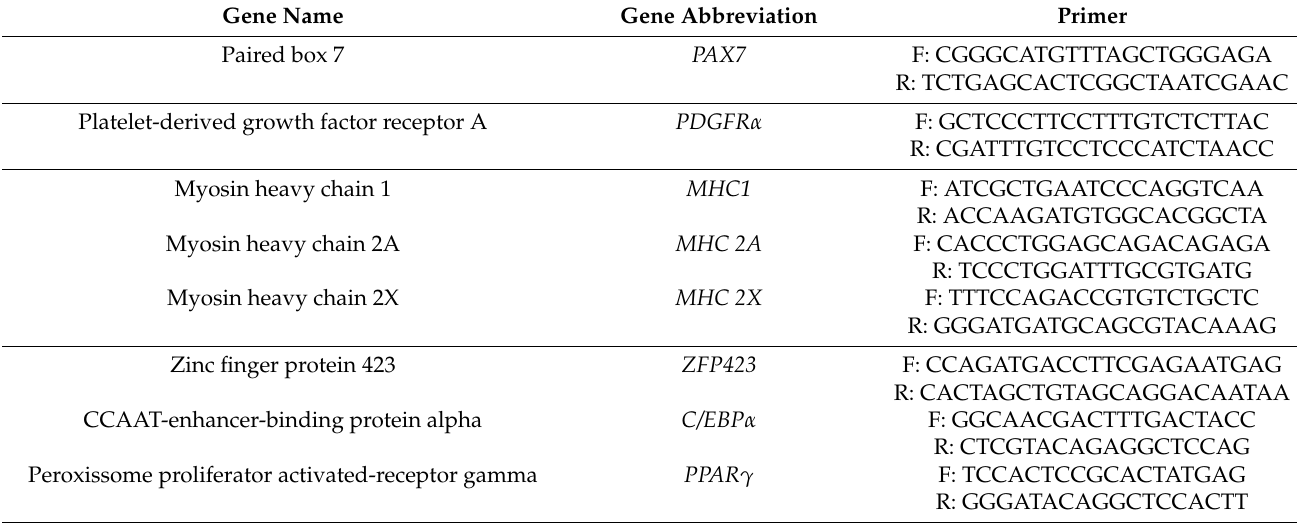
Table 2. List of primers for relative gene expression by